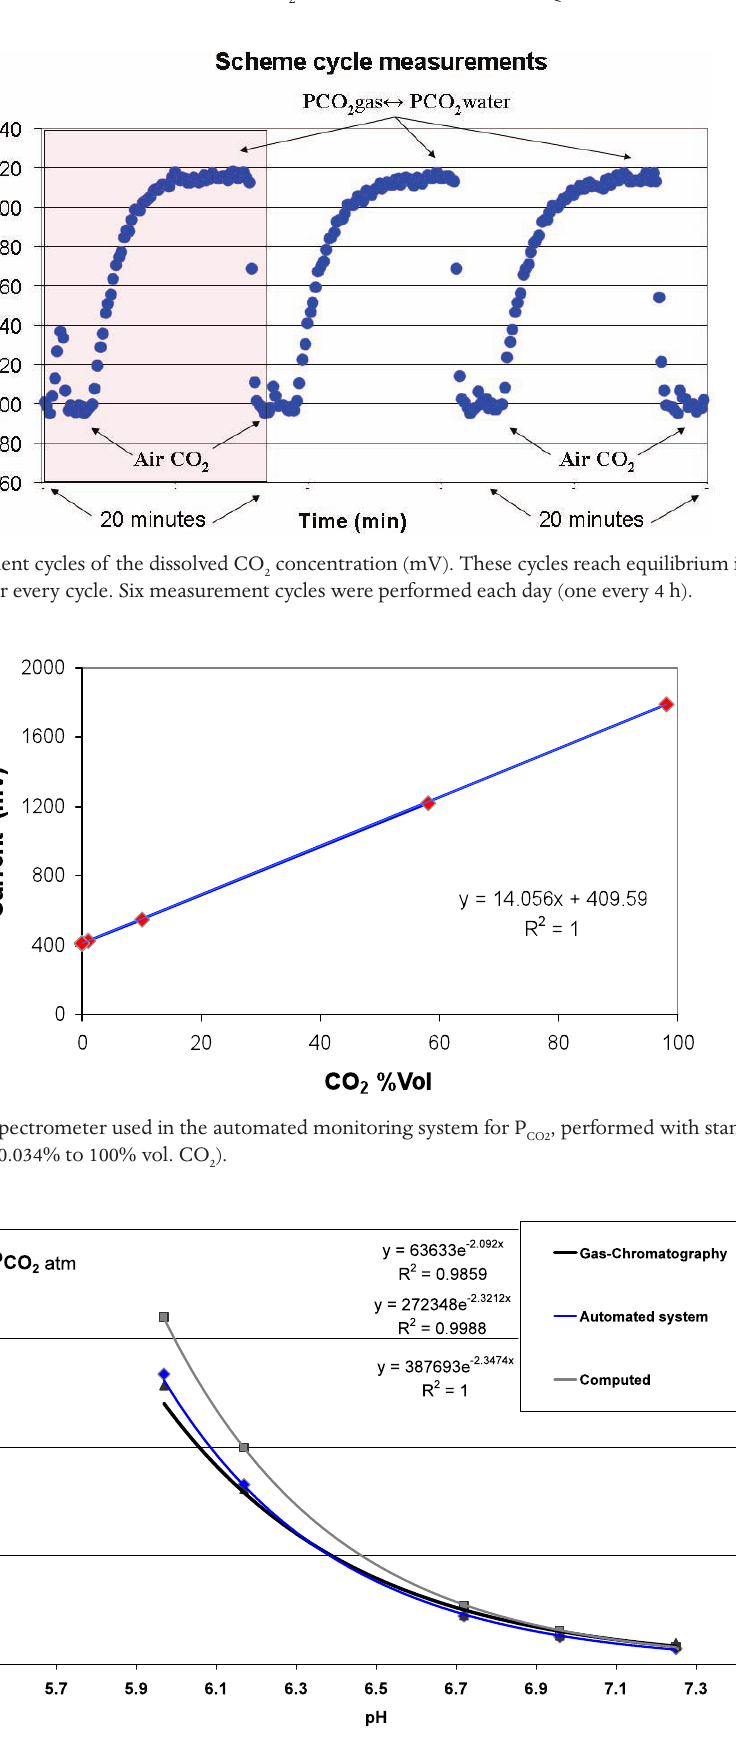
values CO2 content. The different 3